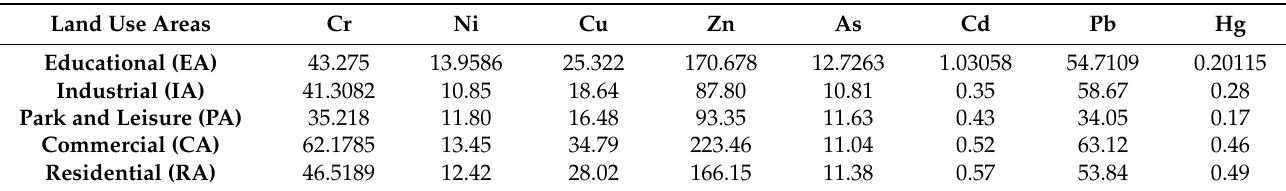
Table 3. Concentrations in various types of land use